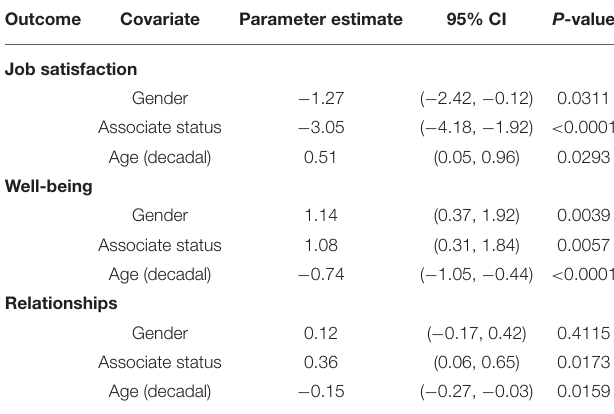
TABLE 2 | Exploratory factor analysis.